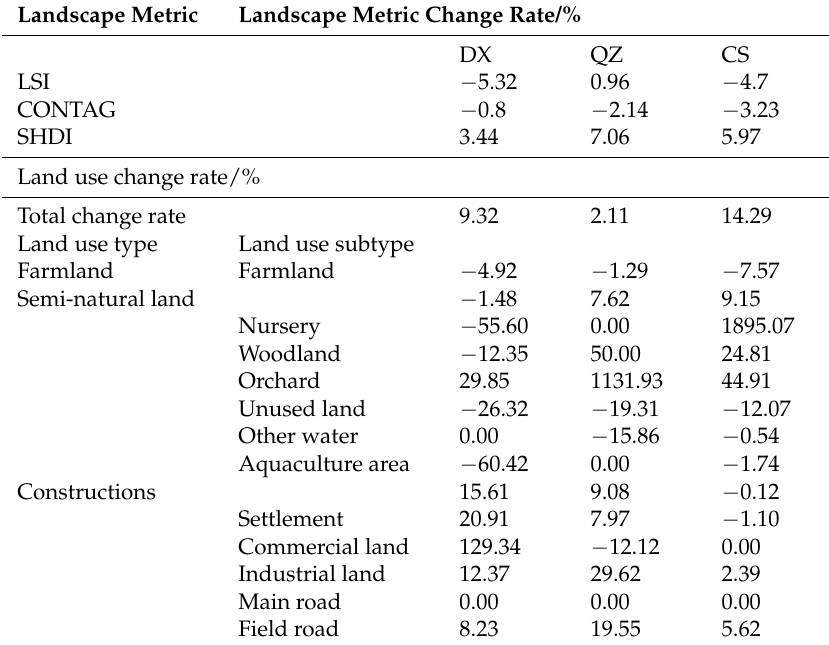
Table 2. Changes in land use and landscape metrics from 2009 to